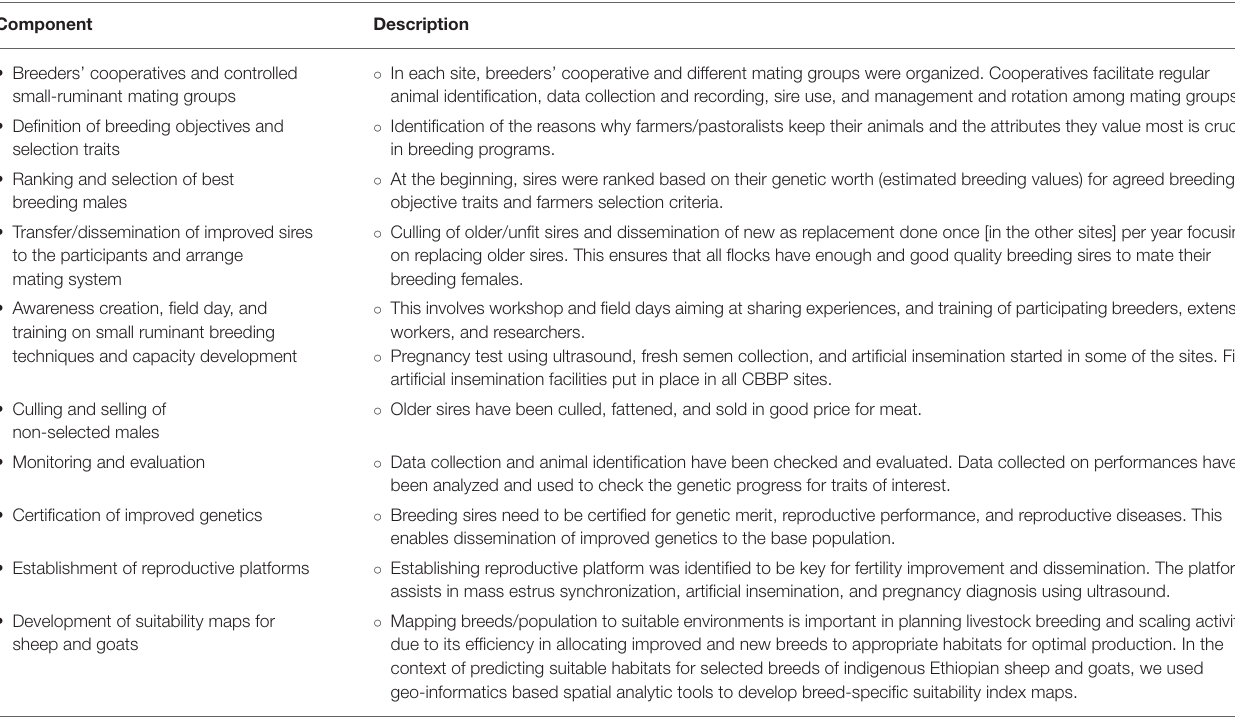
TABLE 1 | Description of the components of the breeding innovation. Component Description